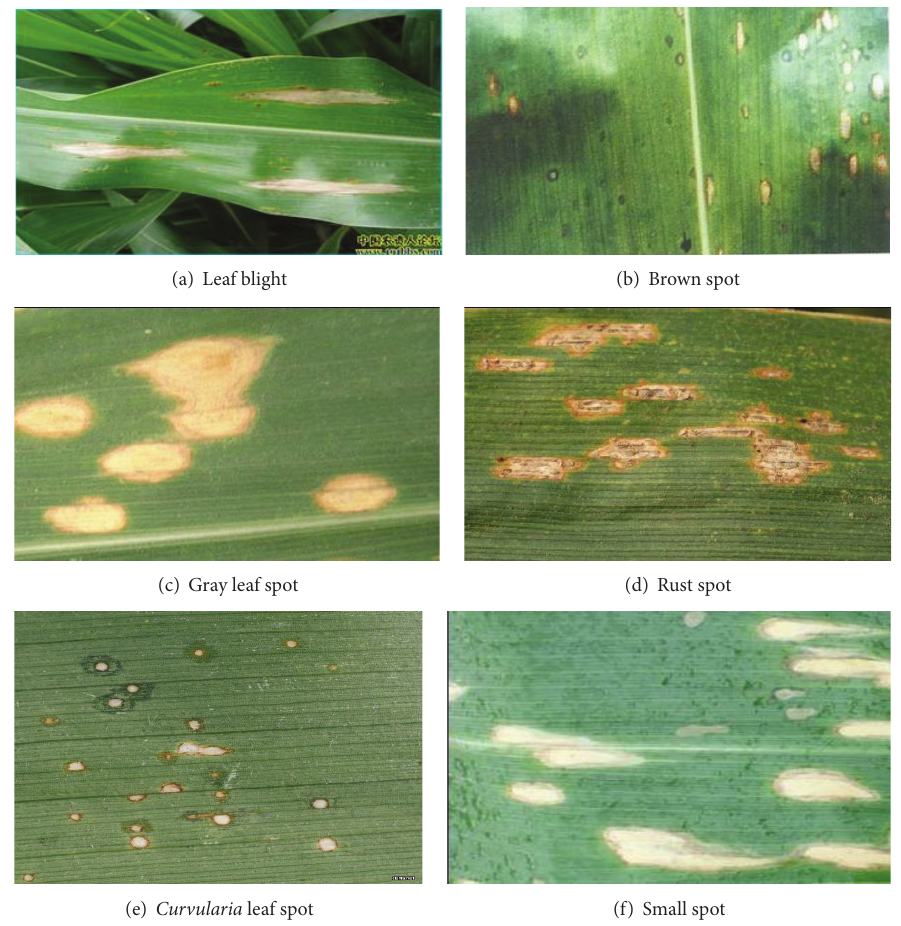
Figure 1: Maize leaf diseases